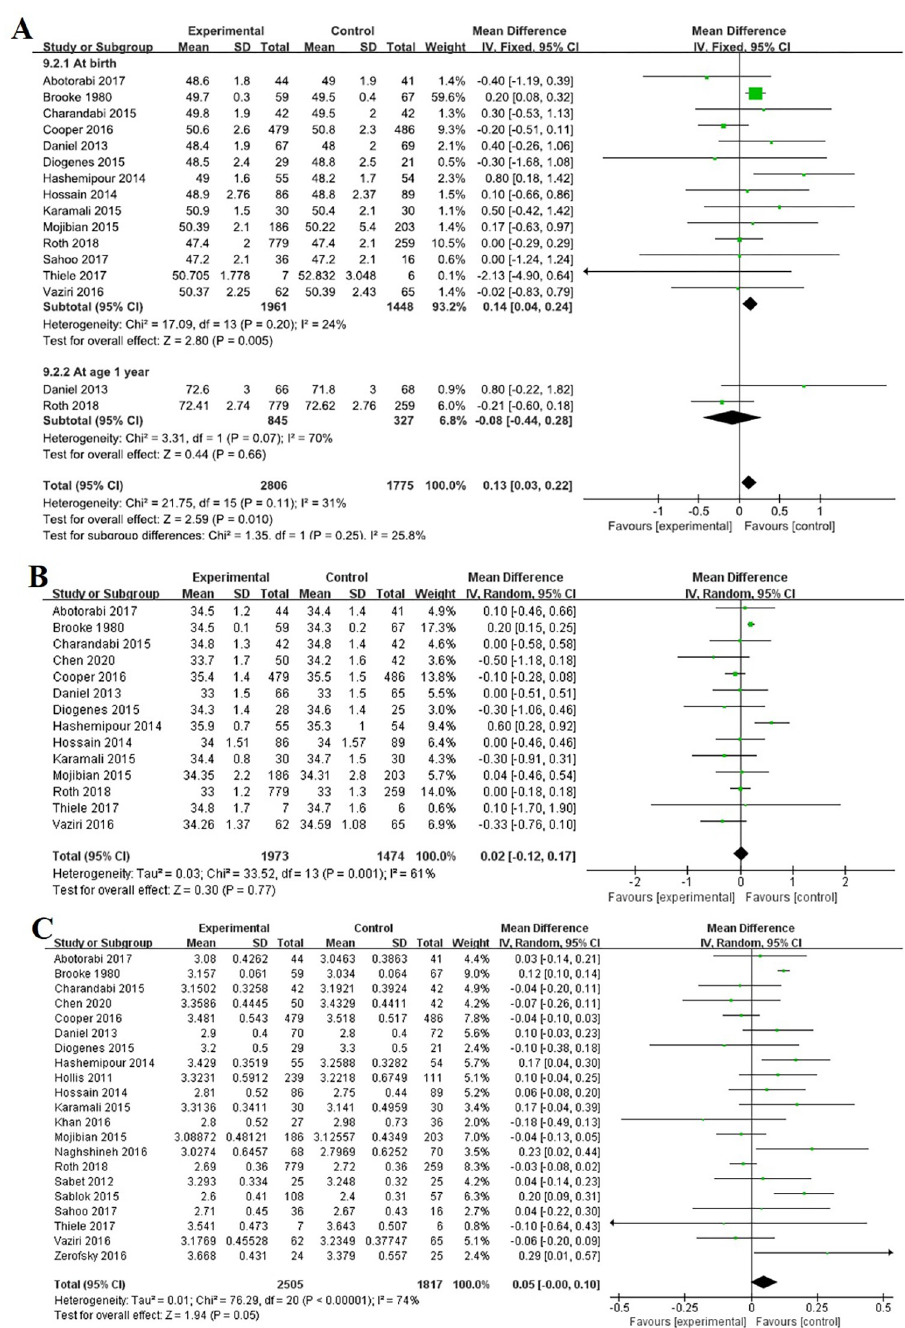
Fig 4. Forest plots of summary crude risk ratios of the association between vitamin D supplementation during pregnancy in the offspring physical growth assessment. Notes: A, Length; B, Birth head circumference; C, Birth